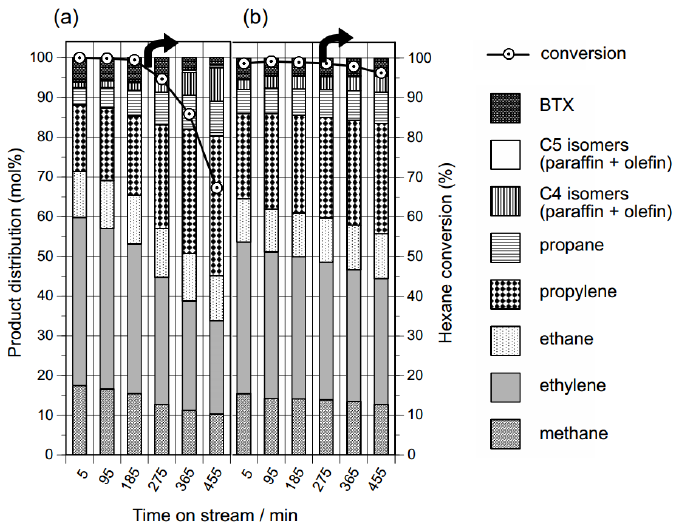
Figure 20. Hexane conversion and product yield (mol %) for hexane cracking over zeolite catalysts at 650 °C. The catalysts are: ( a ) parent H + -ZSM-5 OSDAF (Si/Al = 16.4); and ( b ) deAl(6.0)-ZSM-5 (Si/Al = 22.6). W/F = 19.8 g-cat. h mol − 1 , and partial pressure of hexane = 5 kPa. BTX means the mixture of